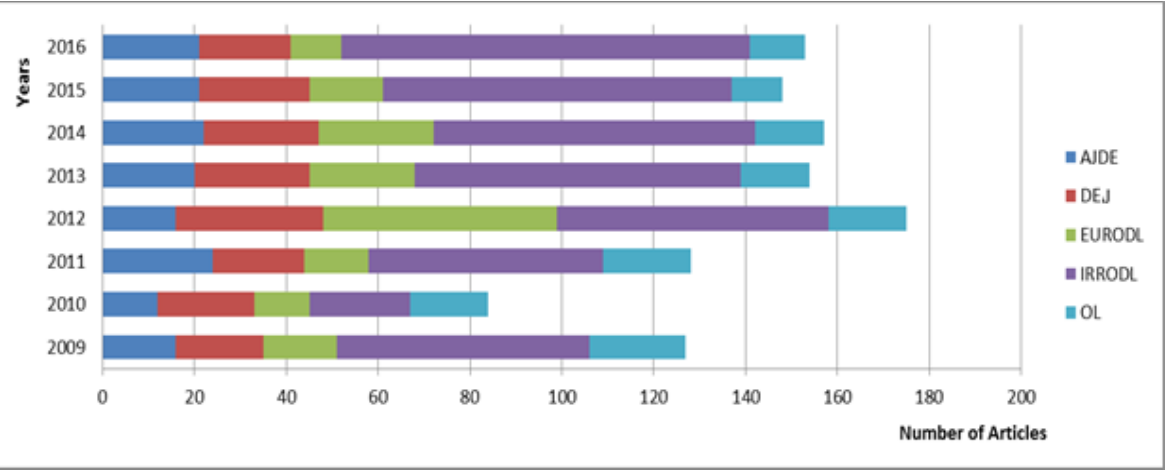
Figure 2. Distribution of the articles by the journals and